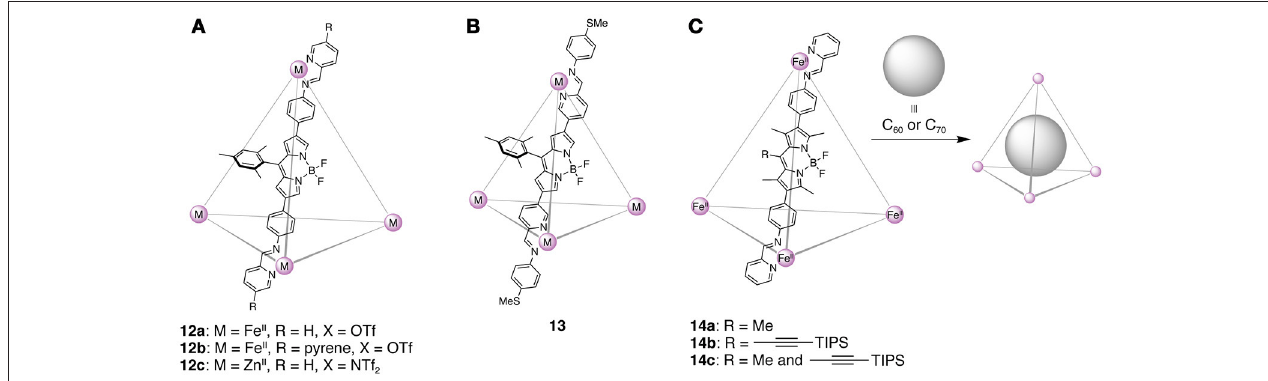
FIGURE 8 | (A) Tetrahedral BODIPY cages 12a – 12c . The structure of only one edge is shown for clarity. (B) Methylthio-substituted tetrahedral cage 13 involved in the autocatalytic system of photooxidation-driven subcomponent exchange reactions. (C) Tetrahedral cages 14a – 14c and encapsulation of fullerenes.